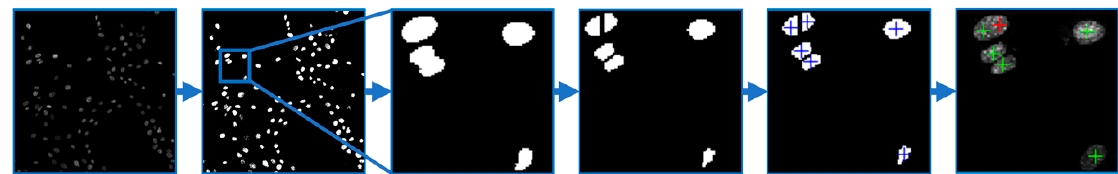
Figure 10. Image processing pipeline for semi-automatic cell counting. From left to right: original grey-scale image processed by a Gaussian low pass filter; thresholded binary image; resized thresholded binary image; image with nuclei divided by a watershed algorithm; image with nuclei with marked centroids; the resulting image of centroids after manual corrections mapped to the original grey-scale image.